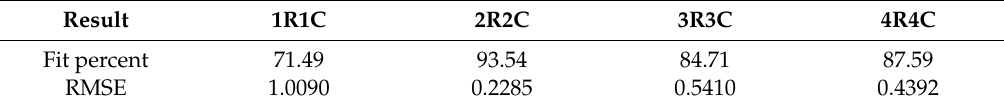
Table 12. Sixty-minute prediction results for experiment